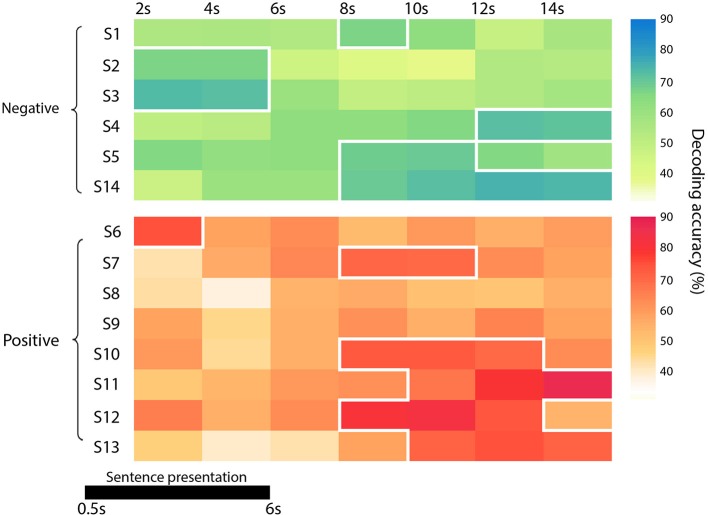
Diagram representing the accuracy of each subject and group (in green the negative one -the funeral of a loved one- and in red the positive event -wedding), at each time point. Significant time points (p < 0.05) are marked with a white border.